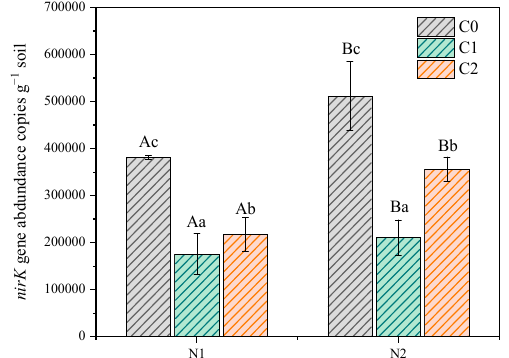
Figure 3. NirK gene copies after inputting straw incorporation and N fertilization application rates in saline-alkaline paddy soils. The different lowercase letters indicate significant difference among straw input amounts of the same N application at p < 0.05. Different capital letters indicate a significant difference among N application amounts of the same straw input at p < 0.05.